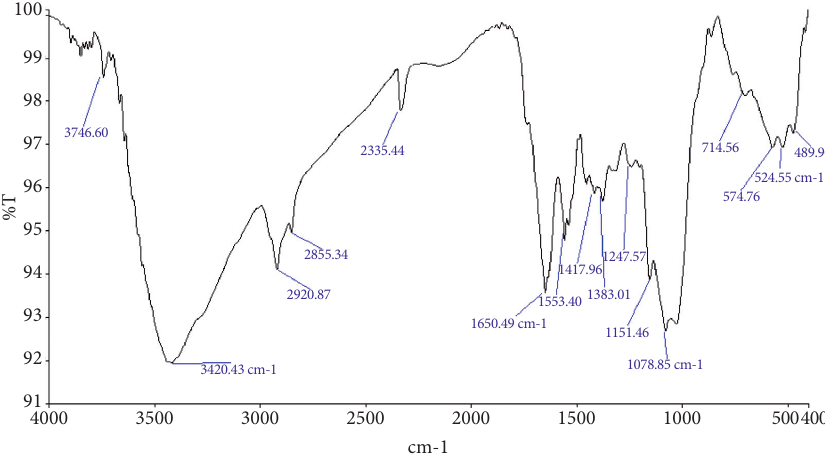
Figure 8: FT-IR spectrum of chitosan/TPP at manufacturing ratio